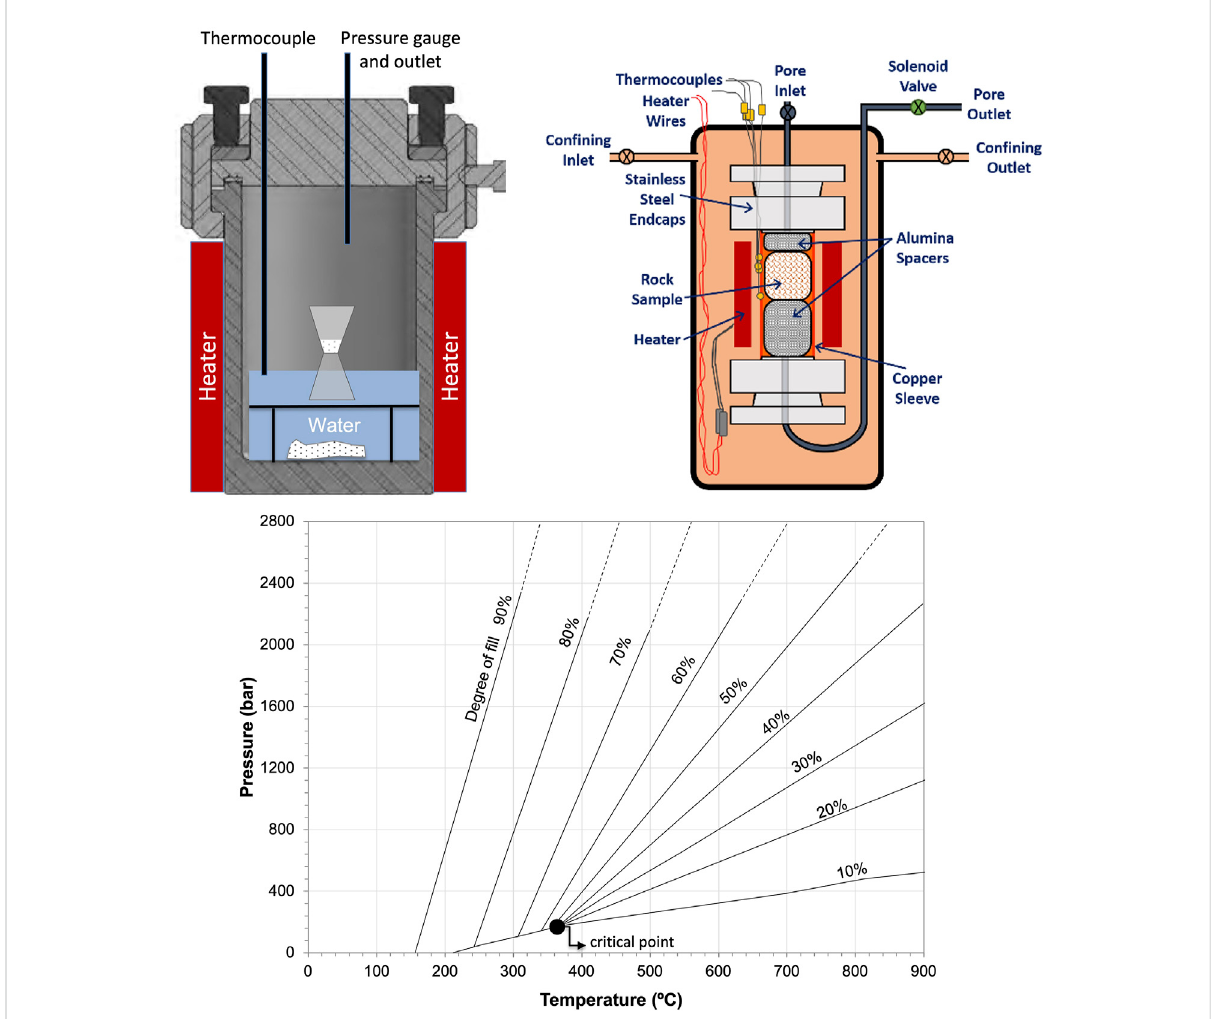
FIGURE 1 Schematics of laboratory autoclave vessel ( top left ) and the in-house built HPHT reactor ( top right ) . In the autoclave vessel, the sediment is placed in water at the bottom of the vessel representing the dissolution zone as well as in an hourglass-shaped sample holder that is partially submerged in water. In the HPHT reactor, the sample is jacketed into a core-holder consisting of a thin-walled, annealed copper tube wrapped by a heater,separatingtheporeandcon fi ningpressuremedia.( Bottom )PTdiagramofwatershowingthe fi llingfactor(degreeof fi ll)oftheautoclave as a parameter. The autogenerated pressure depends on temperature and it is very sensitive to the amount of water present in the volume (i.e., degree of fi